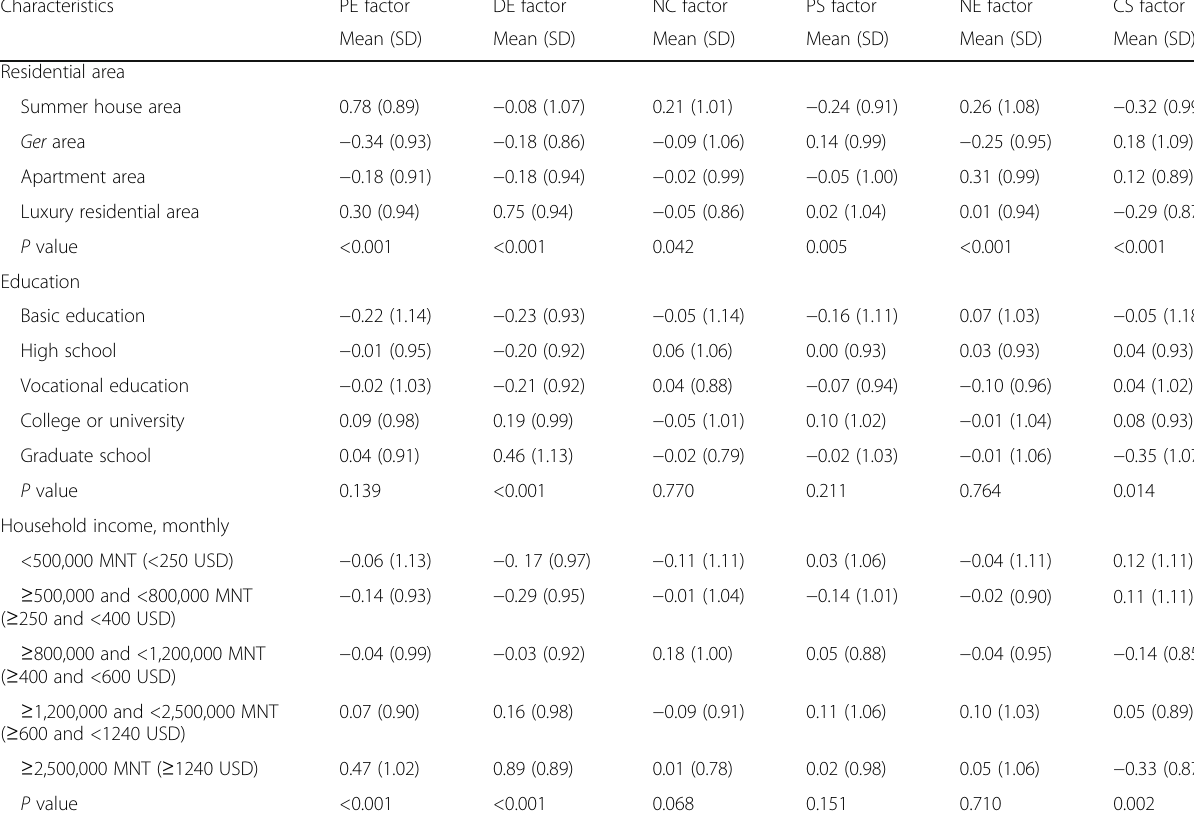
Table 3 Mean factor score of perception of neighborhood environment according to residential area, education, and household income Characteristics